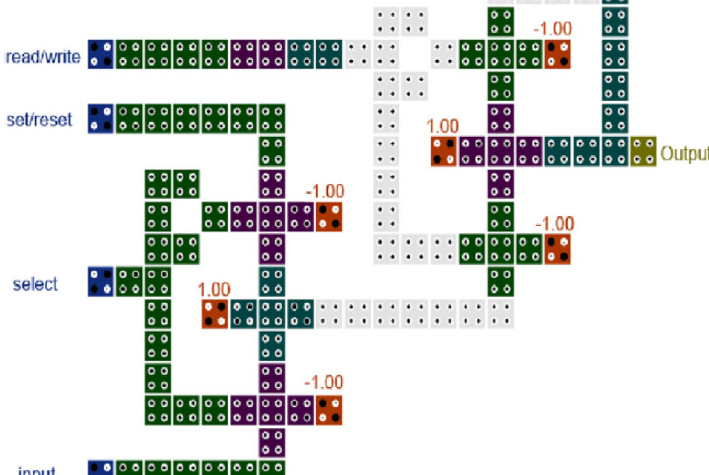
Fig. 4 The developed 1-bit QCA RAM circuit in [15]